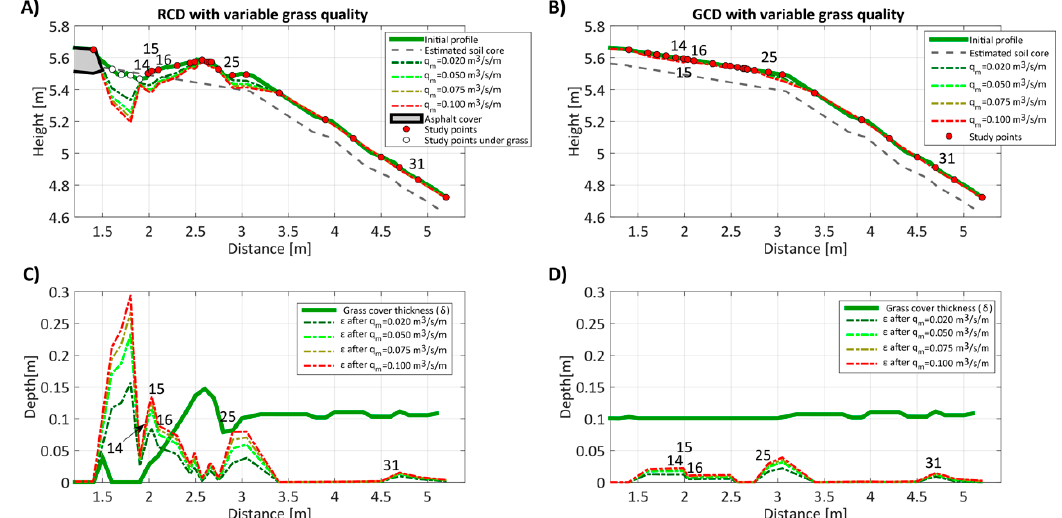
Figure 13. Results of scoured profiles for different q m conditions on with the estimated grass quality for Millingen at each STP for ( A ) RCD and ( B ) GCD. Lower plots show their initial grass cover thickness ( δ ) and the eroded depths ( ε ) after each storm condition for ( C ) RCD and ( D ) GCD.